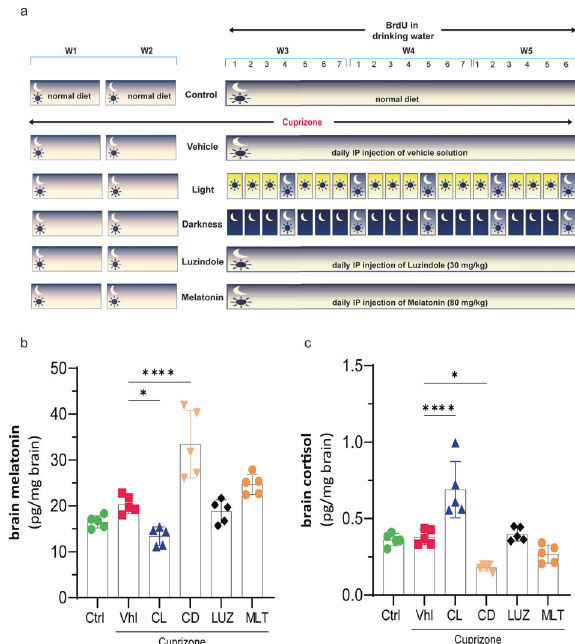
Fig. 1 Schematic representation of the treatment protocols. a Brie fl y, the mice were fed CPZ for 2 weeks under a normal light/ night cycle. Thereafter, treatments were initiated at the beginning of Week 3 in the presence of CPZ. Both the Ctrl group and the vehicle (untreated CPZ) were kept on a normal light/night cycle. The melatonin (80 mg/kg) and Luzindole (30 mg/kg) groups received these drugs by IP daily at 9 AM and 6 PM, respectively, and were maintained on a normal light/night cycle. Light was set ON or OFF for 3 days in the constant light or constant darkness groups, respectively, followed by one day of normal light/night. This cycle was repeated 5 times. BrdU in drinking water was started at the beginning of the manipulations in Week 3. b Brain levels of melatonin and ( c ) cortisol were analyzed using ELISA at the end of the study ( n = 5 mice/group). Signi fi cance is indicated by ∗ p < 0.05, ∗∗ p < 0.01, and ∗∗∗∗ p <